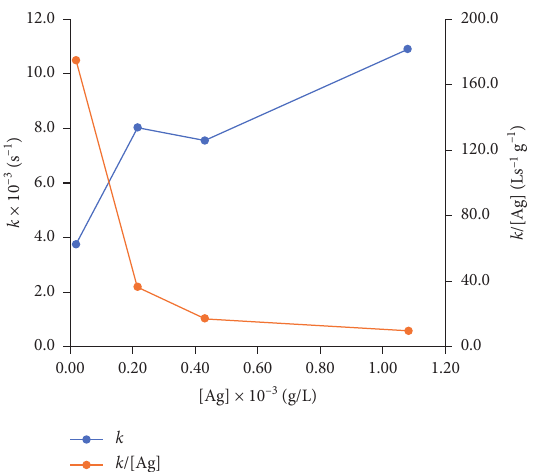
Figure 10: Changes of apparent rate constants k and k /[Ag] with the concentration of AgNO